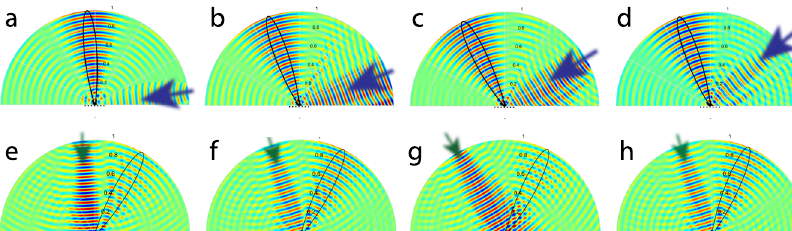
Fig. 6 Full-wave simulation results for nonreciprocal re fl ective beamsteering at 5.8 GHz for a – d forward wave incidence, and e – h backward wave incidence for nonreciprocity examination. a θ i = 80°. b θ i = 70°. c θ i = 60°. d θ i = 50°. e θ i = − 5°. f θ i = − 20°. g θ i = − 28.5°. h θ i = −